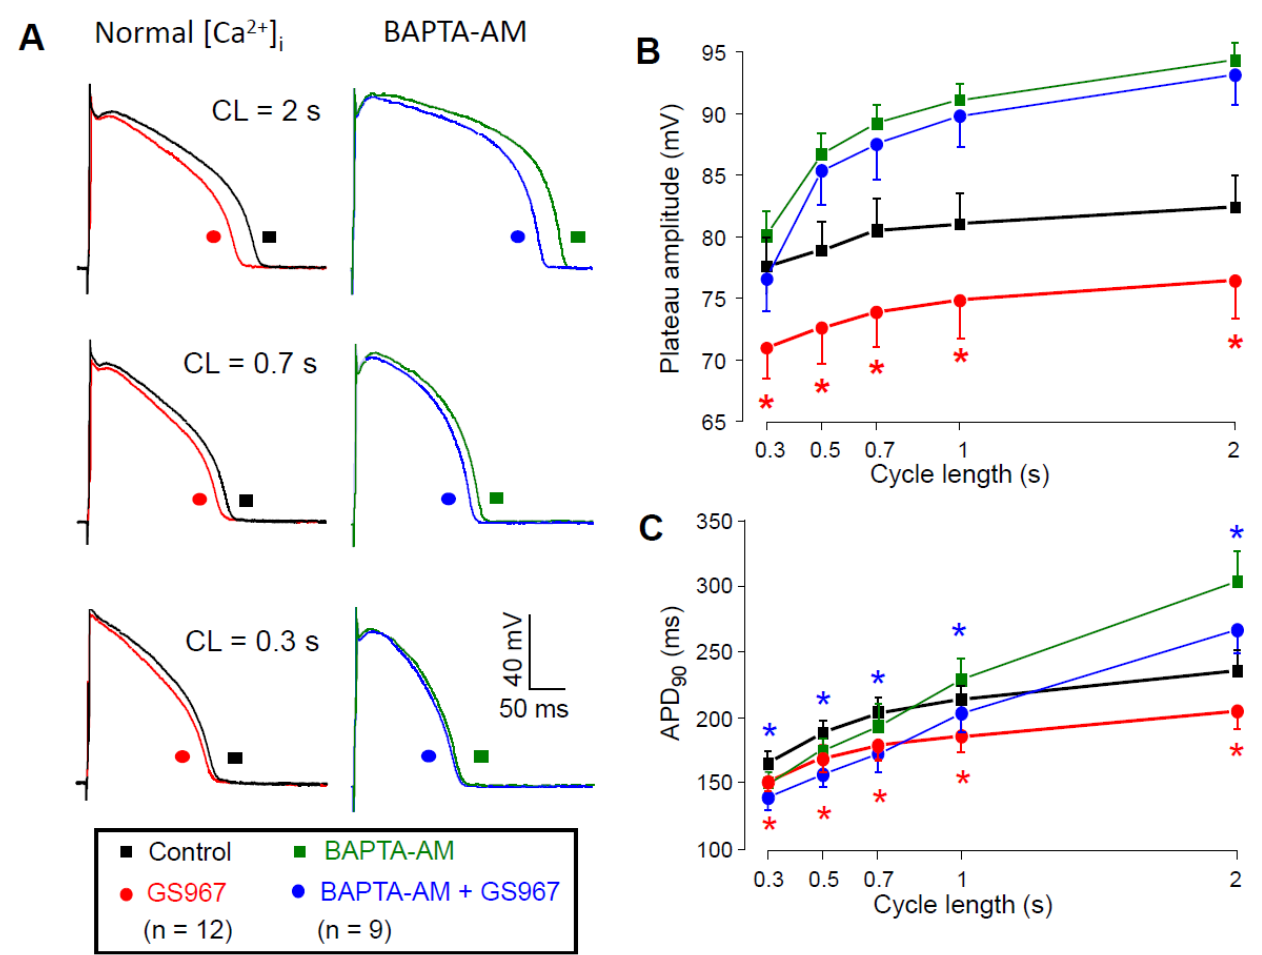
Figure 7. Effects of GS967 on AP configuration. ( A ) Superimposed AP pairs recorded in control and after superfusion with 1 µM GS967 at various pacing cycle lengths. These experiments were performed either under conditions of normal Ca 2+ cycling (left side), or after pretreatment with 5 µM BAPTA-AM for 30 min (right side). ( B , C ) Effects of GS967 on plateau amplitude ( B ) and AP duration ( C ), as a function of the pacing cycle length. Symbols and bars are mean ± SEM, numbers in parentheses indicate the number of myocytes studied, asterisks denote significant differences between data obtained before and after the application of 1 µM GS967. Accordingly, red asterisks indicate significant differences in control (i.e., GS967 versus control), while blue asterisks indicate significant differences obtained in the presence of BAPTA-AM (i.e., GS967 + BAPTA-AM versus BAPTA-AM).